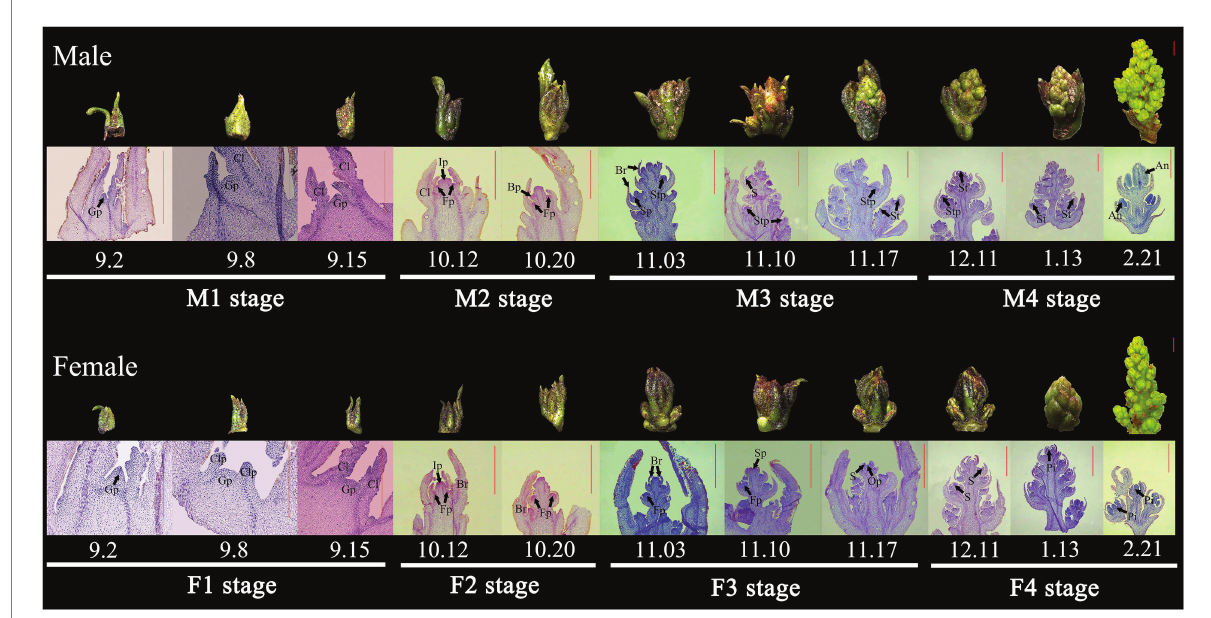
FIGURE 1 The vital periods of floral sex differentiation and organogenesis in Z. armatum . An, anther; Br, bract; Bp, bract primordium; Cl, compound leaf; Clp, compound leaf primordium; Fp, floral primordium; Gp, floral growing point; Ip, inflorescence primordium; Op, ovule primordium; Pi, pistil; S, sepal; Sp, sepal primordium; St, stamen; Stp, stamen primordium. The bar was 1 mm, and the decimals was the date to collect the samples. For example, 9.2 present the 2